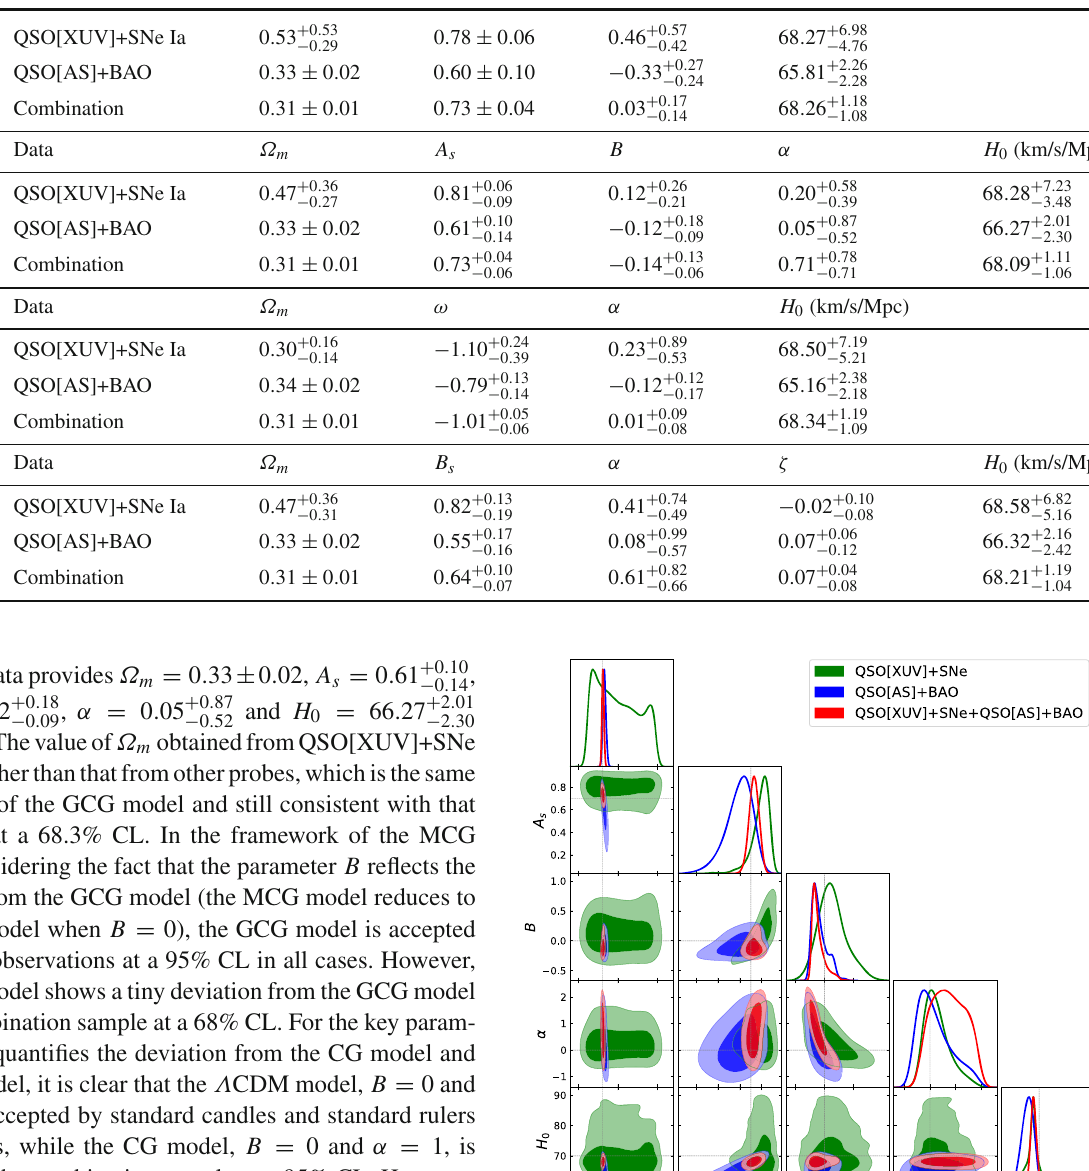
Table 2 The best-fit values and 68% confidence limits for the CG cosmological parameters in each model (GCG, MCG, NGCG, and VGCG) and data set (QSO[XUV]+SNe Ia, QSO[AS]+BAO, and QSO[XUV]+SNe Ia+QSO[AS]+BAO) Model